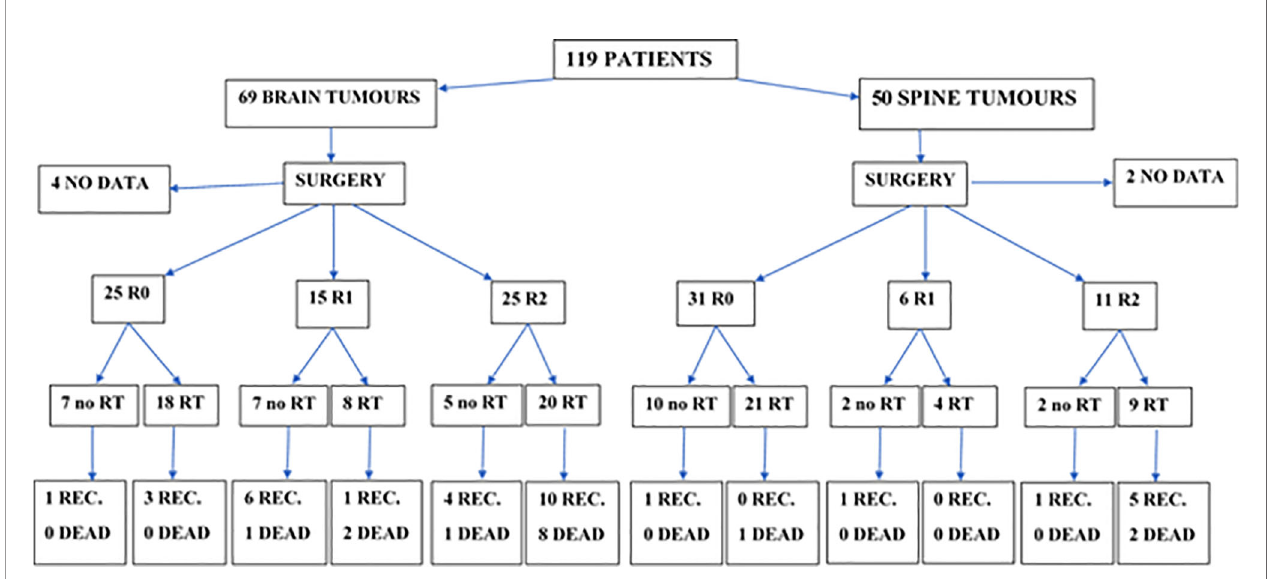
FIGURE 1 | Primary treatment and treatment results in patients with brain and spinal tumors (CTH not included, used in the treatment of 5 patients with brain tumors after R2 resection in 4 of them and R1 in one, and in one patient with spinal tumor and lacking data about the extent of resection; all of them received RT in primary treatment). REC, recurrence; RT, radiotherapy; R0, radical resection (macro- and microscopically); R1, macroscopically radical resection (but not microscopically); R2, macroscopically not-radical